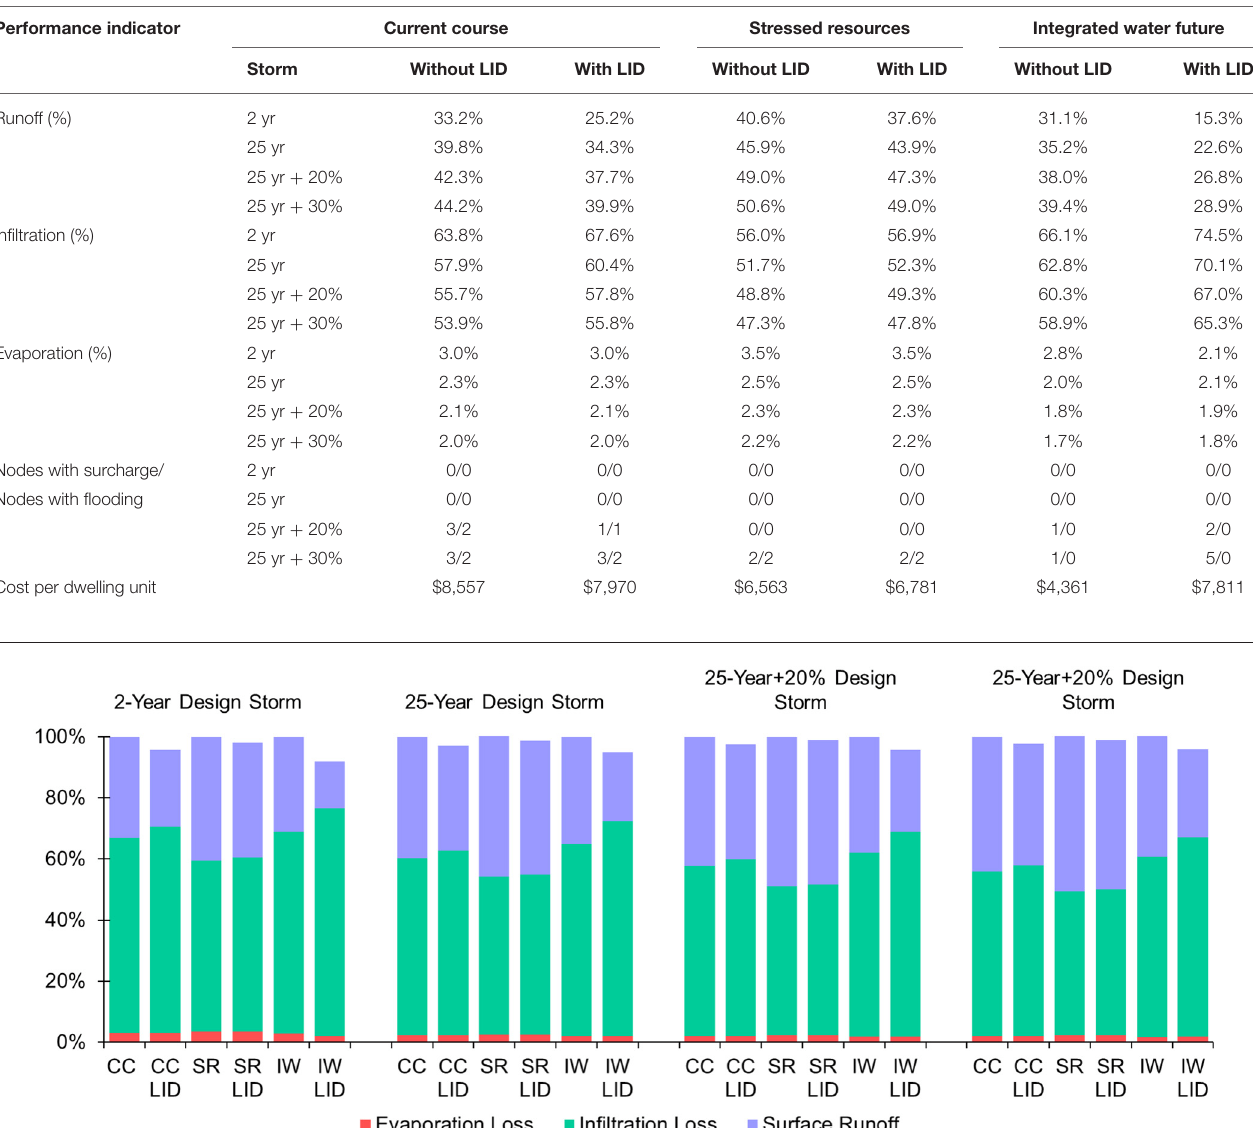
TABLE 2 | Performance indicators for 2 year and all versions of the 25 year design storms for scenarios, both without and with LID. Performance indicator